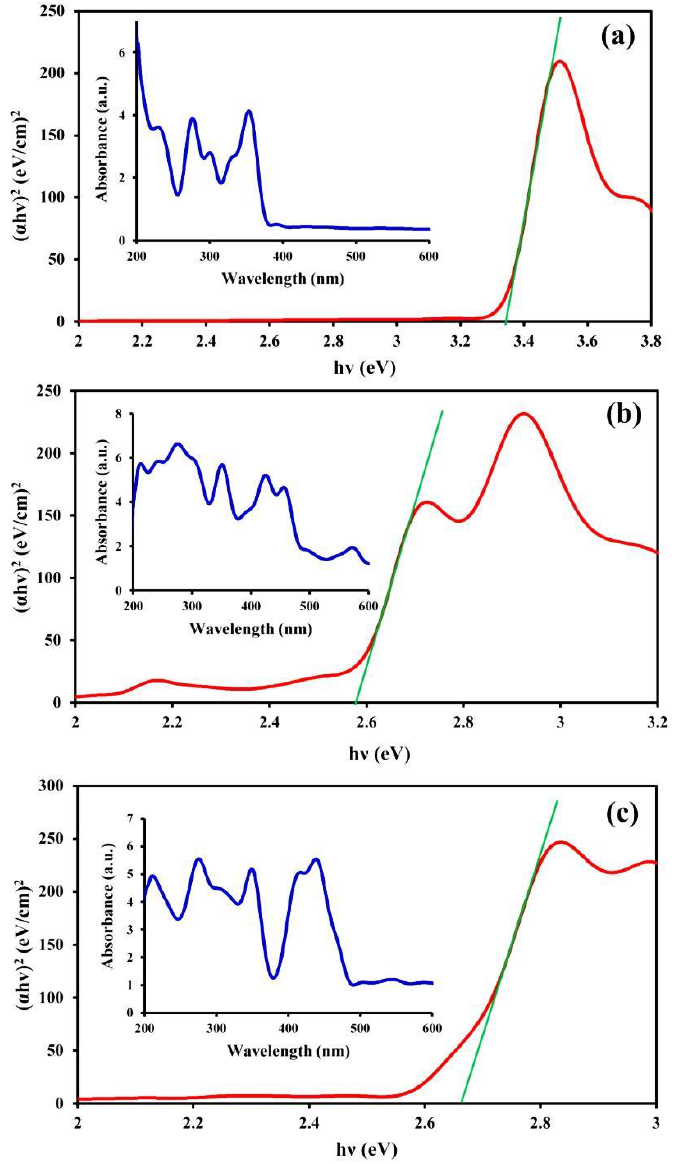
Figure 3. DRS spectra of CM ( a ), MNPs ( b ) and CM/MNPs/CA ( c ) along with the corresponding band gap energies.